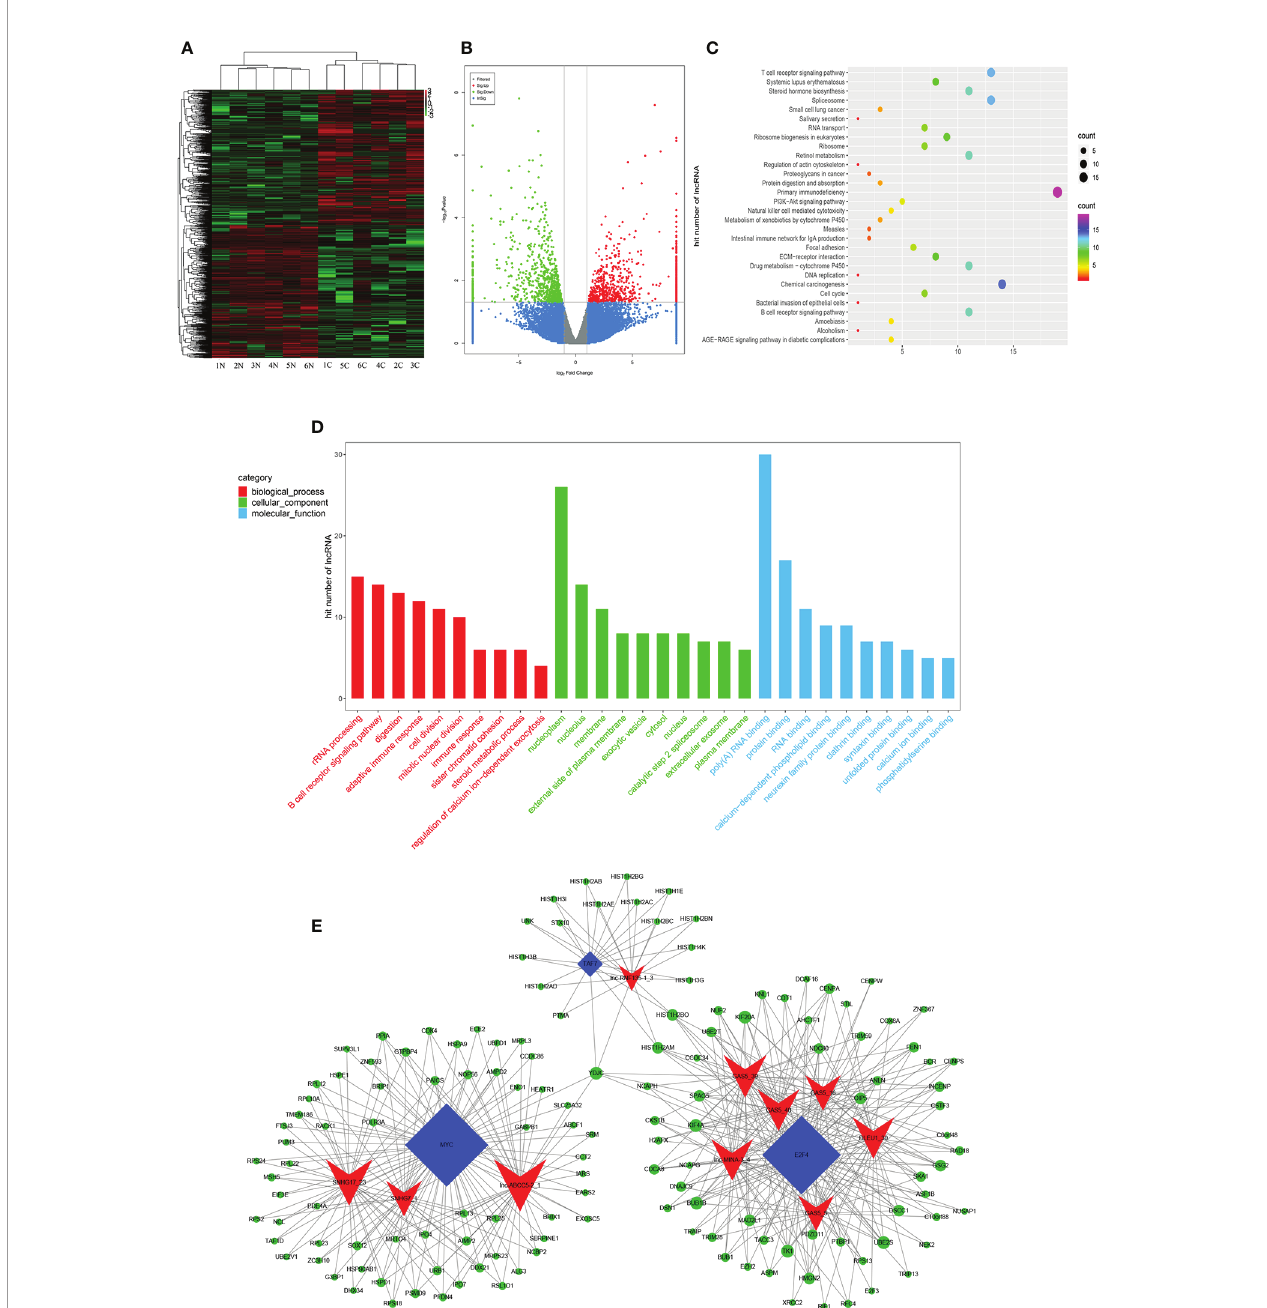
FIGURE 3 | Pro fi ling of lncRNAs in GC tissues compared to adjacent mucosa. (A) Heat map shows the upregulated and down-regulated lncRNAs in cancer vs normal group. (C for cancer, and N for normal mucosa). Each column represents the expression pro fi le of a tissue sample, and each row corresponds to a lncRNA. High expression level is indicated by “ red ” and lower levels by “ green ” . (B) Volcano plot shows tp-regulated and down-regulated circRNAs in cancer vs normal group. Higher expression levels are indicated by “ red ” , lower expression levels are indicated by “ green ” , and no signi fi cant difference is indicated by other colors. (C) KEGG analysis of lncRNAs in cancer vs normal group. (D) GO analysis of lncRNAs in cancer vs normal group. (E) TF-lncRNA-targetgene network